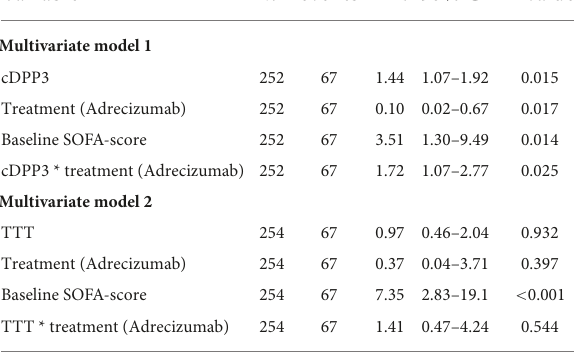
TABLE 2 Multivariate risk models of treatment interaction with circulating dipeptidyl peptidase 3 (cDPP3) (model 1) and time until start of treatment (model 2).